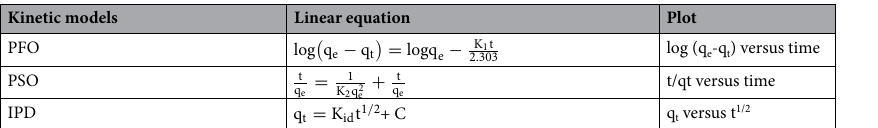
Table 6. Differential and linear forms of pseudo-first order (PFO), pseudo-second order (PSO) and intraparticle diffusion models (IPD).